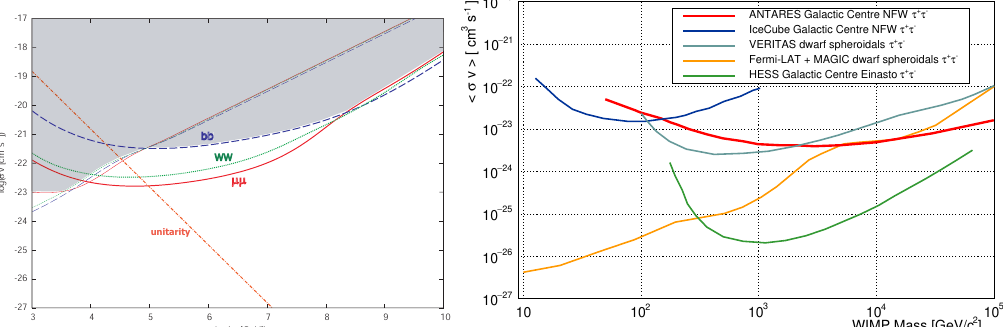
Figure 10: Left panel : neutrino (thick curves) and cascade gamma-ray (thin curves) constraints on the annihilation cross section of very heavy DM. The shaded region is determined by taking the more stringent of the neutrino and gamma-ray bounds, for the least constrained of the three channels. Reproduced from Ref. [ 115 ] . Right panel : updated limits for masses below 100 TeV for the sample channel of annihilation to τ leptons, using observations of the Galactic Center. Reproduced from Ref. [ 116 ]